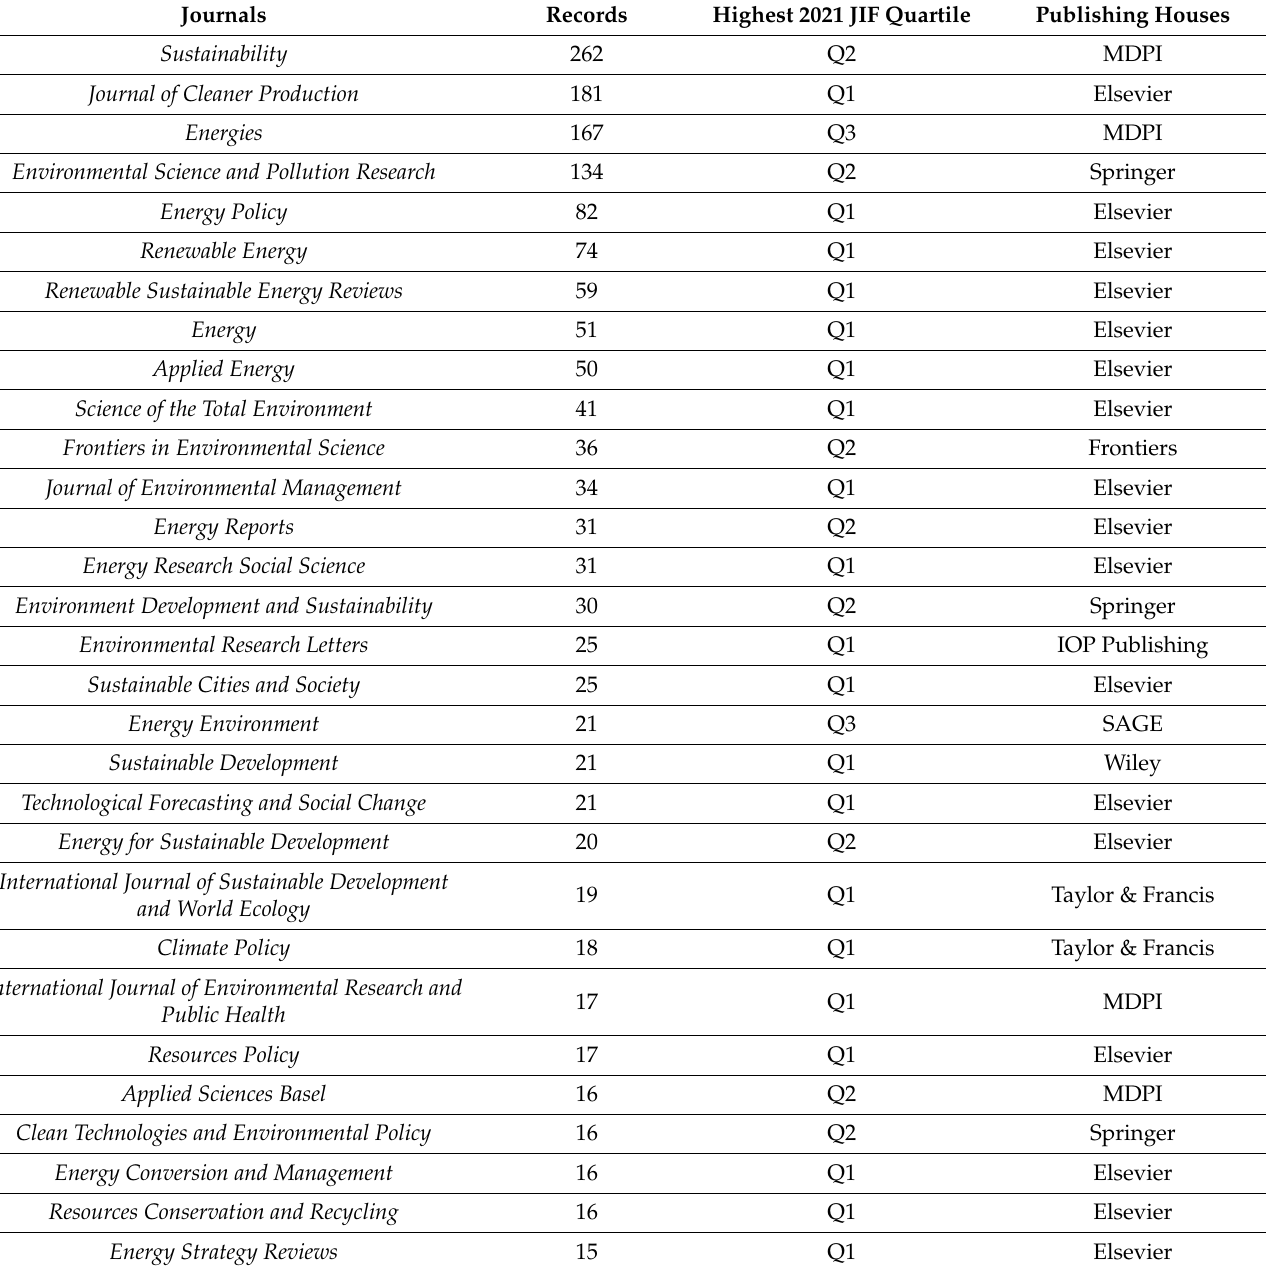
Table 5. List of journals by number of records (Top-30) and their 2021 Journal Impact Factor (JIF)